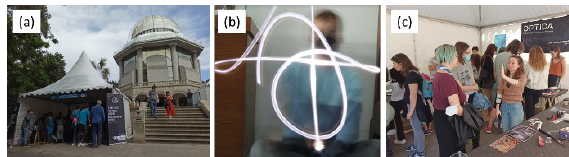
the House of Sciences of A Coruña. b) Long-exposure photography experiment. c) Disseminating optics to a varied